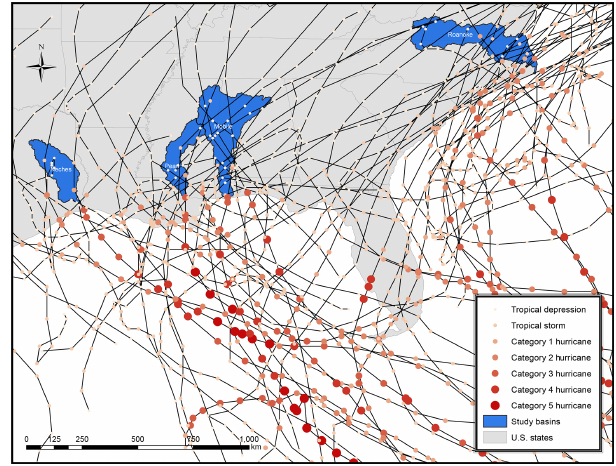
Figure 1. Location of the study basins analyzed in this study (blue); colored dots represent points along the tracks of all tropical cy- clones since 1998 that have impacted the study basins, where the color/size of the dot indicates the severity of the storm at that location (see legend). (Hurricane track data were retrieved from NOAA’s Atlantic hurricane database, HURDAT2 (Landsea et al., 2015); basin boundary data were retrieved from USGS’s National Hydrography Dataset, NHD, and Watershed Boundary Dataset, WBD (USGS, 2016); basemap is from